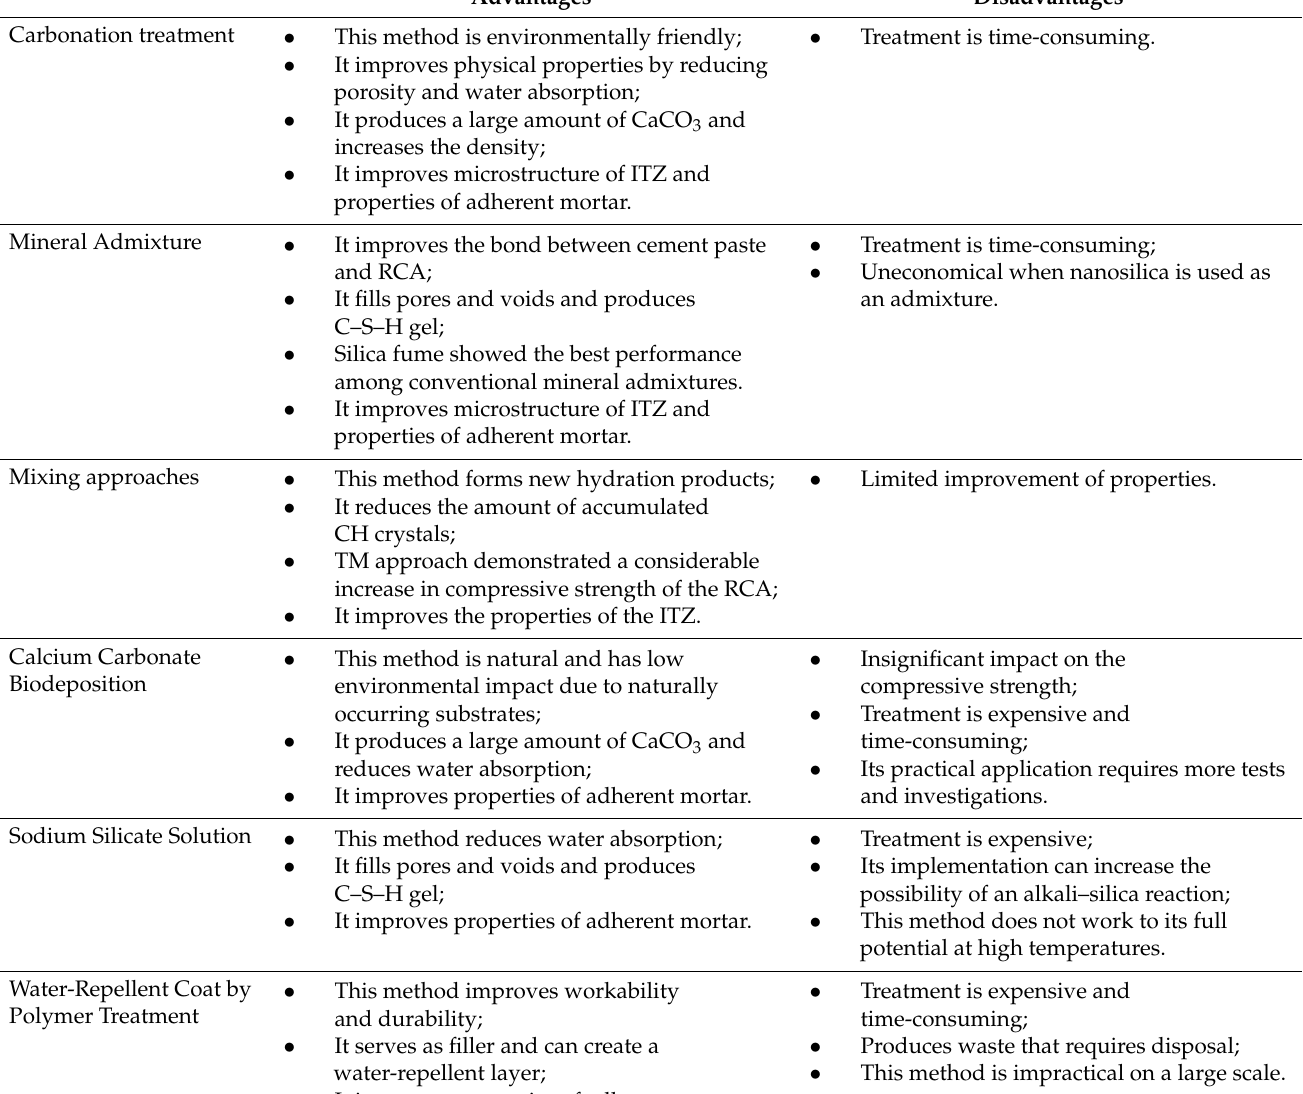
Table 8. Advantages and disadvantages of improvement methods for ITZ and adherent